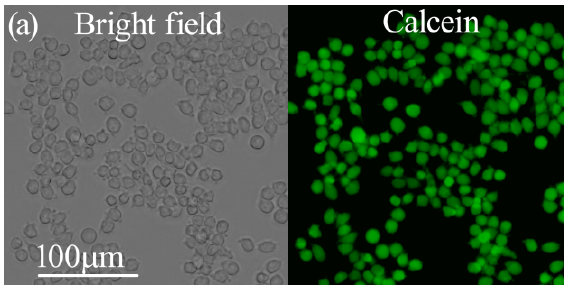
Figure 3. The live stains for RAW264.7 cells after incubation with different sized NCBs for 24 h. ( a ) Control cells; ( b , c ) Cells after incubation with ( b ) 50 μ g·mL − 1 and ( c ) 200 μ g·mL − 1 Printex 90; ( d , e ) Cells after incubation with ( d ) 50 μ g·mL − 1 and ( e ) 200 μ g·mL − 1 Printex G; ( f , g ) Cells after incubation with ( f ) 50 μ g·mL − 1 and ( g ) 200 μ g·mL − 1 Flammruss 101. The scale bar corresponds to 100 μ